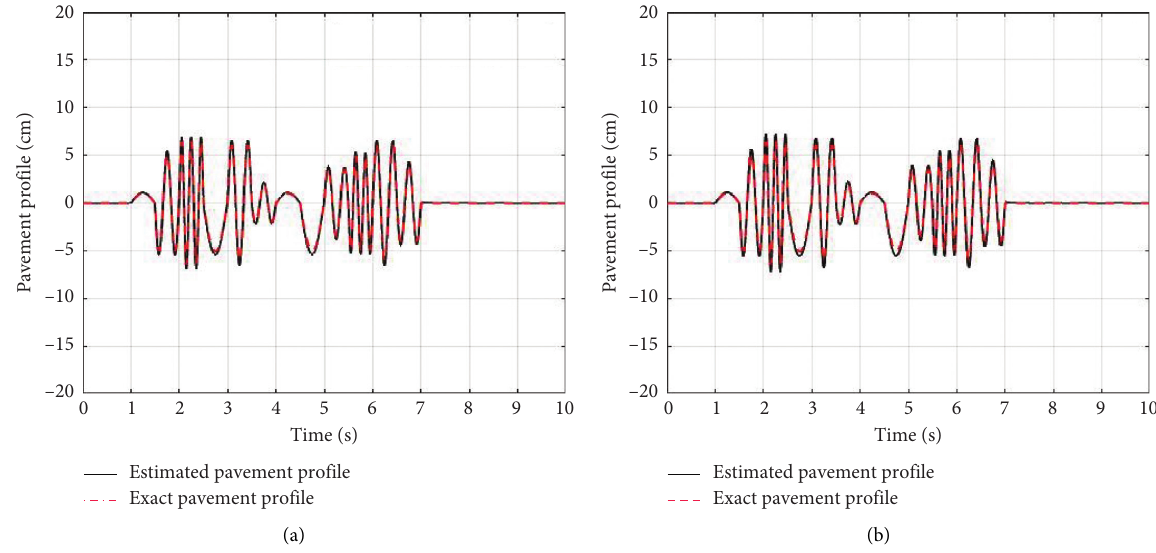
� 10.67rad/s and ζ � 0 . 5. n